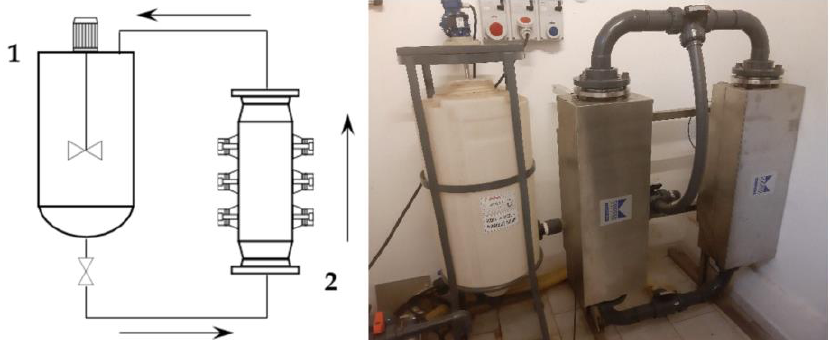
Figure 5. Recirculating flow system used in Grillo et al. [50]. Left: set-up scheme (1: mixed tank; 2: US flow-through cell); and right: facility picture.